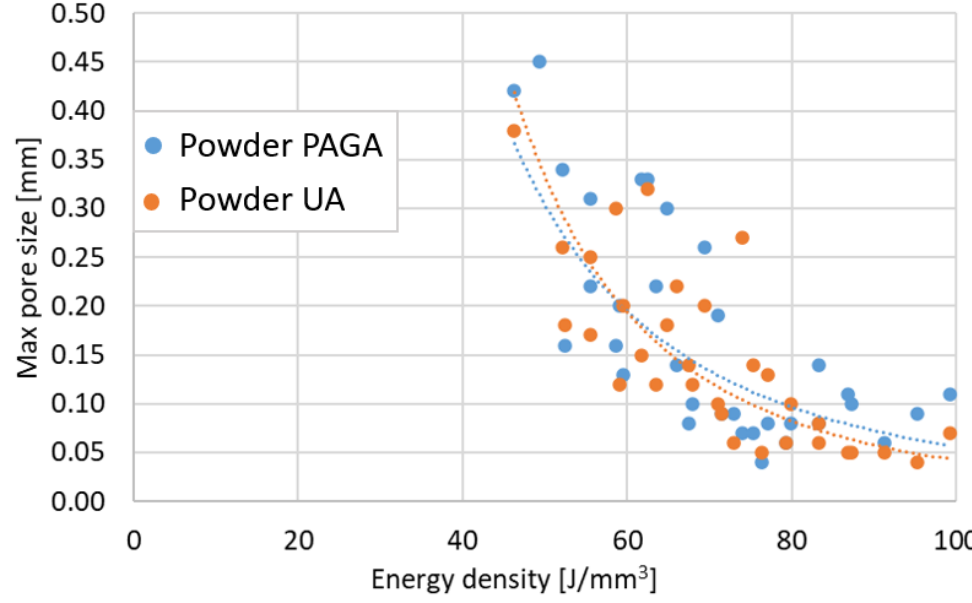
Figure 8. Maximum defect sizes in the function of the laser energy density ρ E